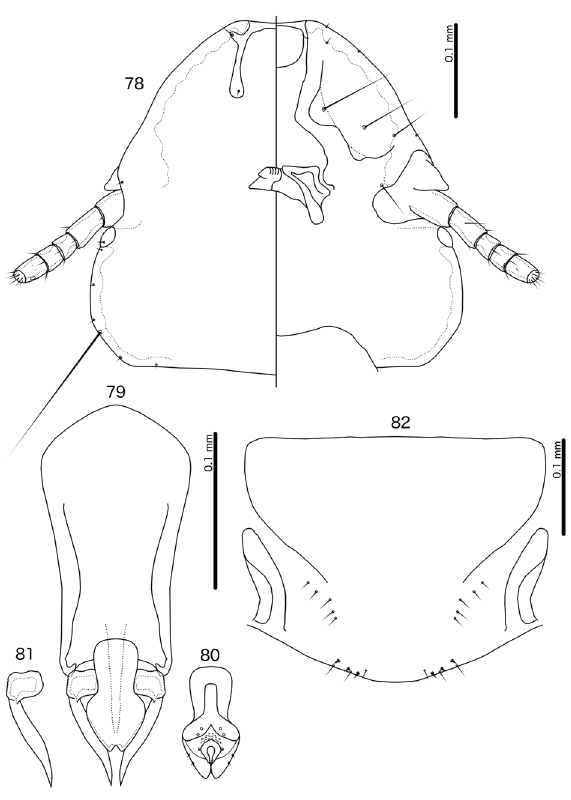
dus iliacus Linnaeus, 1758 78 Male head, dorsal and ventral views 79 Male genitalia, dorsal view 80 Male mesosome, ven- tral view 81 Male paramere, dorsal view 82 Female subgenital plate and vulval margin, ventral